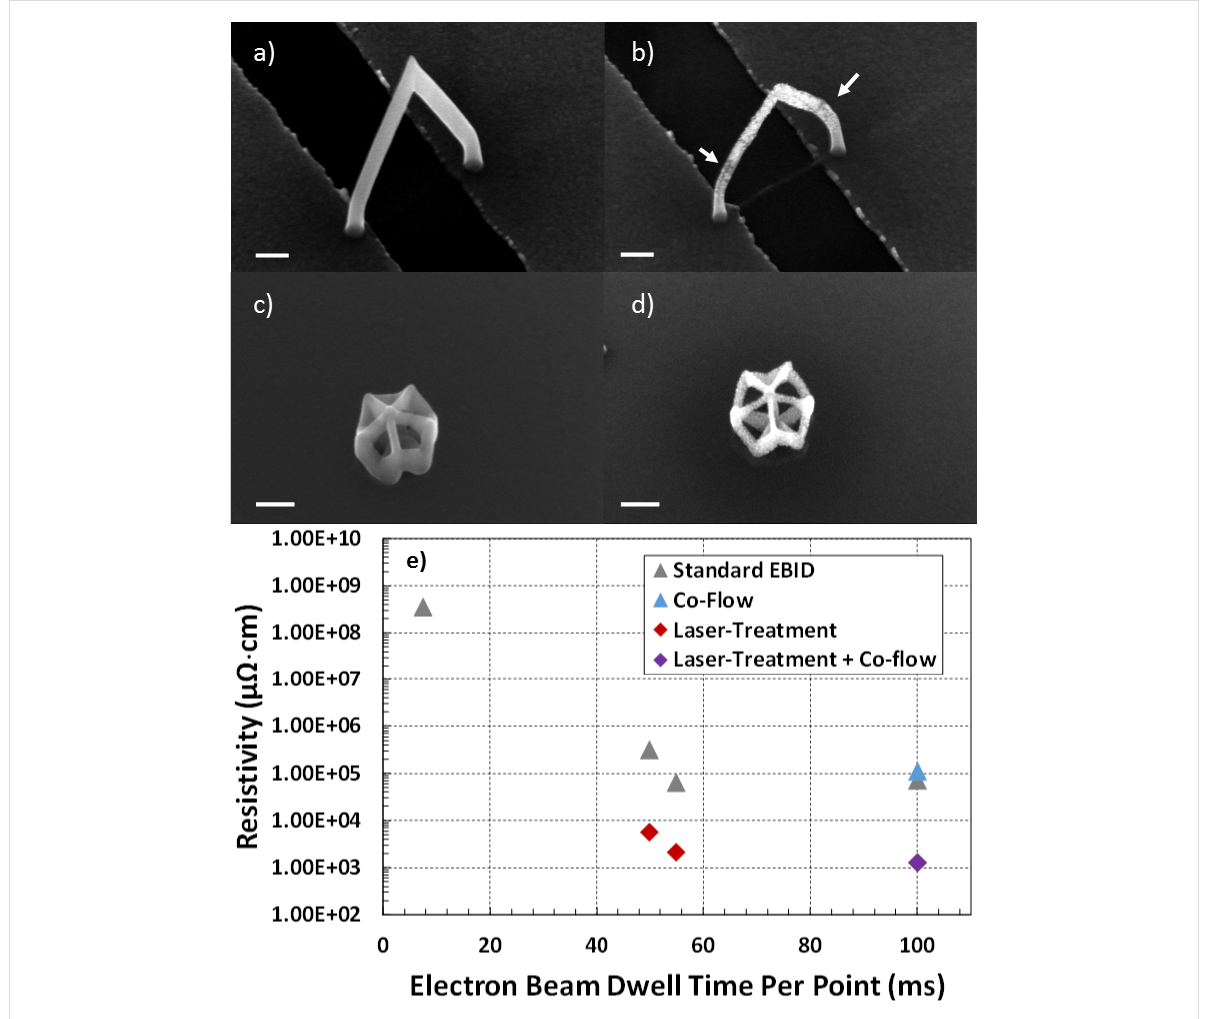
Figure 4: SEM images (scale bar length is 100 nm) of suspended nanowires grown across a ≈ 500 nm gap using a dwell time per point of 100 ms a) without laser treatment or a reactive co-flow and b) with both a reactive gas co-flow and laser assist. 10-sided polygons constructed c) without laser-assist and d) with laser-assist using a 10 µs pulse width with a pulse frequency of 100 Hz. e) is a plot of the resistivity of suspended nanowires as a function of beam dwell time under different growth conditions (see legend). The white arrows in part b highlight the morphological transition from standard EBID-like (darker) to higher purity